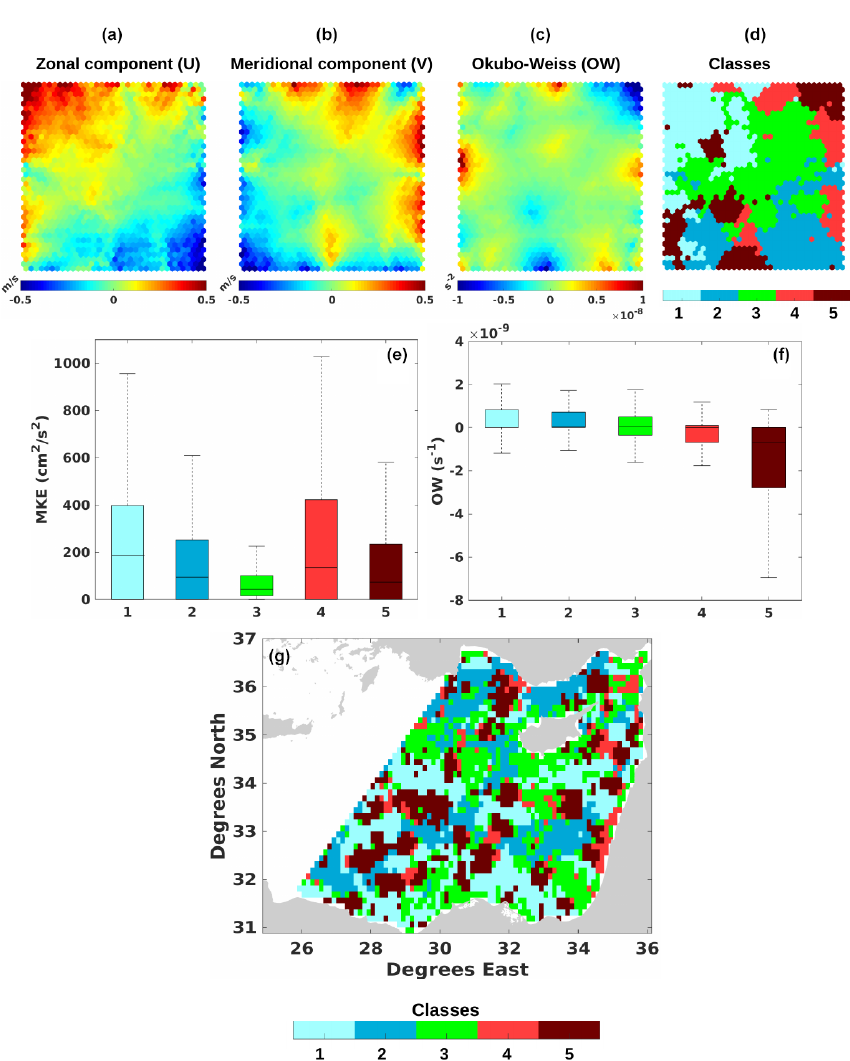
Figure 2. Panels (a–c) reveal the topological maps of three variables, U , V , and OW, respectively, using an SOM after the training phase. Each map shows the recorded values by each neuron for the three variables. The resulting clusters obtained from the SOM and HAC method are shown in (d) . Mean kinetic energy (MKE) and OW values of each cluster are shown in the boxplots in (e) and (f) , respectively. A random example (25 June 1998) of the decomposition of daily surface currents into the five clusters is presented in (g)